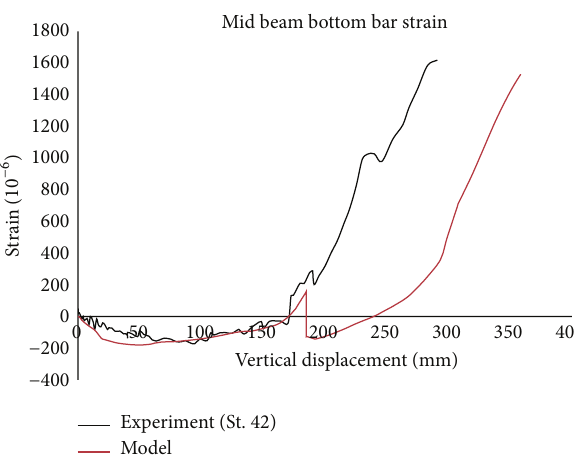
Figure 22: Strain in bottom reinforcing bar at mid span of